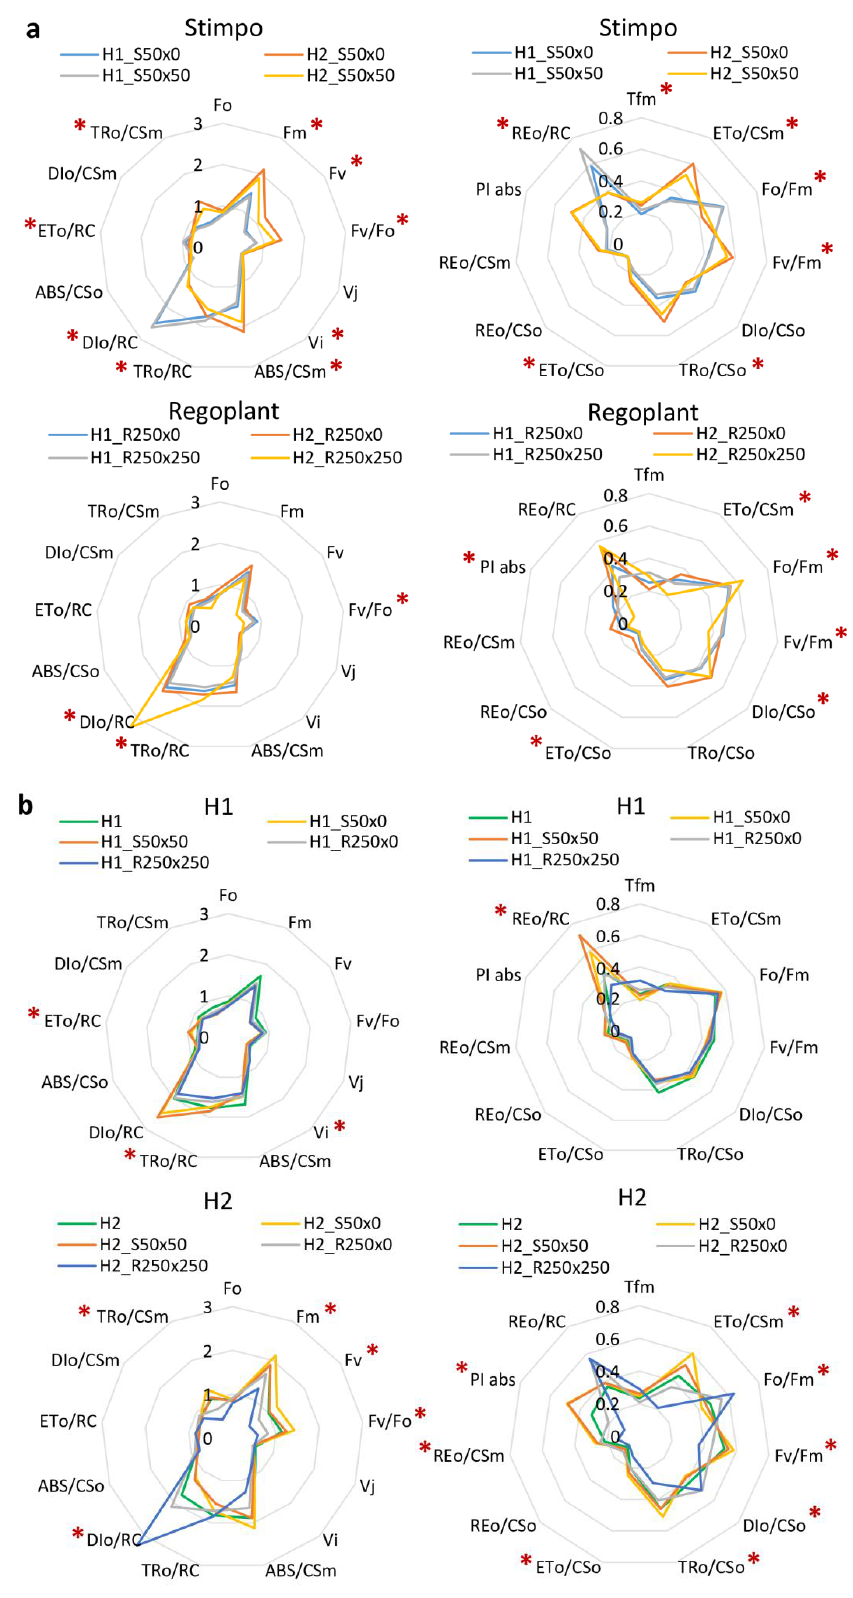
Figure 4. Physiological indexes for different PGRs treatment grouped by PGR ( a ) and soil ( b ); red asterisks (*) marks indexes with significant differences ( p < 0.05). The data of different metrics were normalized for optimal presentation; original data can be found in Supplementary Table S1.